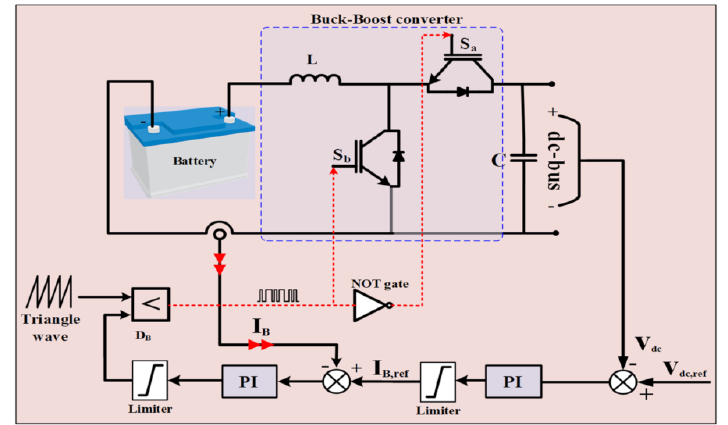
Figure 6. The battery control